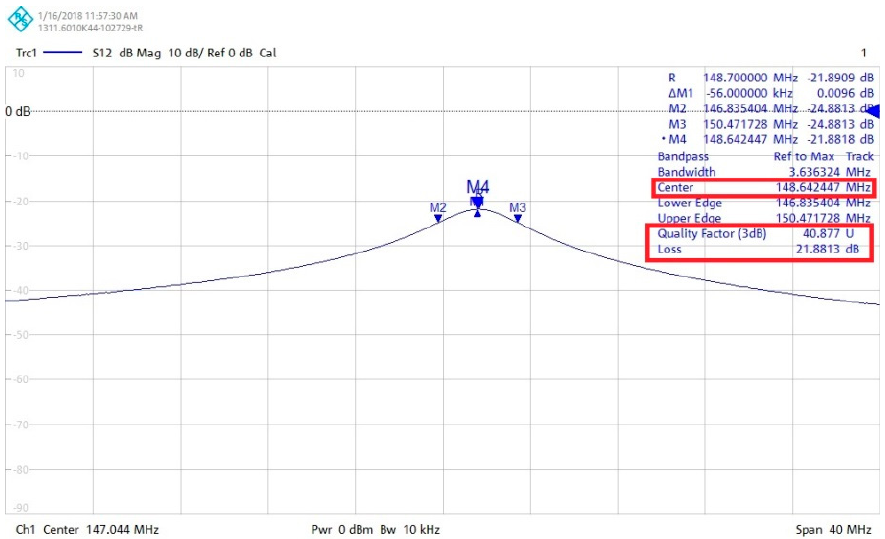
Figure 12. Measured S-34, that is, the cross-talk between a long and a small pickup. Obtained values (marked) at the resonance frequency are the quality factor (Q factor) and the S-coupling.